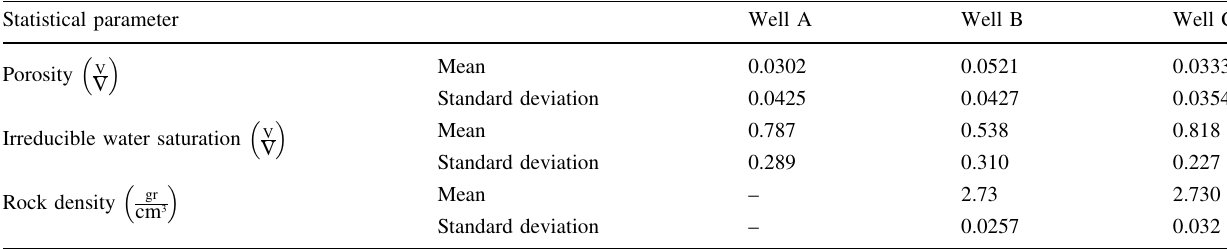
Table 3 Statistical analysis of log data in each of wells (A, B, and C) Statistical parameter Well A